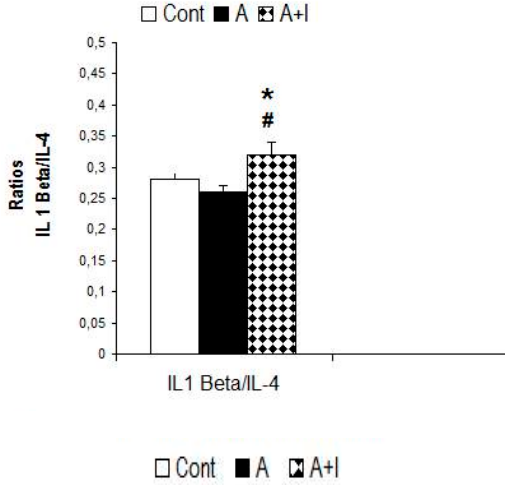
Figure 7. IL-1 Beta / IL-4 ratio in patients with long-term titanium implants and amalgams. Cont : control ( n = 30). Amalgam (A, n = 55). Dental titanium implants + Amalgams (A + I, n = 57). * p < 0.05 vs. Cont, # p < 0.05 vs. Amalgam (A).